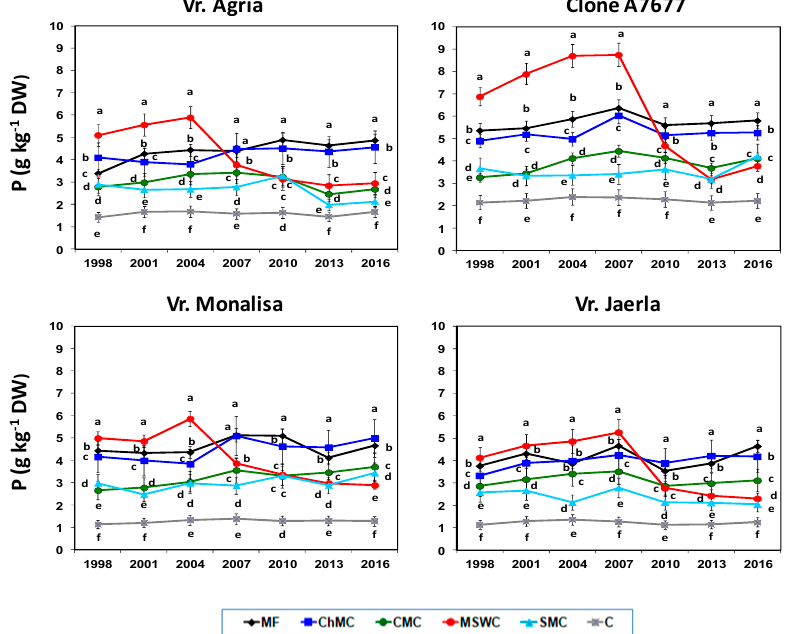
Figure 5. Evolution of the phosphorus content (g kg − 1 DW DW) in potato tubers of the Agria, Monalisa, Jaerla and clone A7677 varieties (1998–2016) versus the application of compost from di ff erent organic amendments. The means with di ff erent lowercase letters within each season indicate significant di ff erences between the treatments ( p < 0.001). Bars stands for standard deviations MF: mineral fertilizer; ChMC: chicken manure compost; CMC: cow manure compost; MSWC: municipal solid waste compost; SMC: sheep manure compost; C: